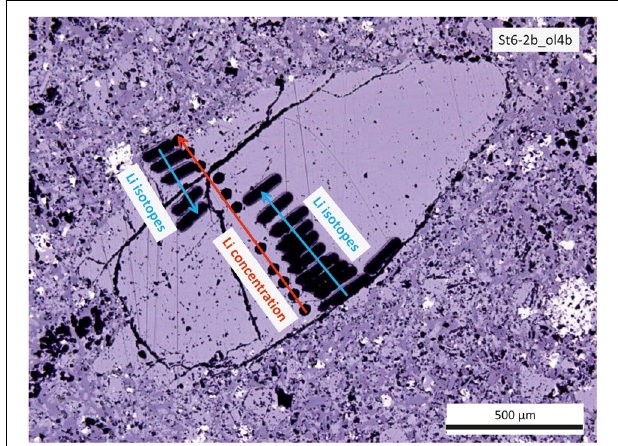
FIGURE 1 | Photomicrograph (reflected light) of sample St6-2b_ol4b showing the positions for major and trace element and isotope analyses. Black dots are from laser ablation for trace element analyses (indicated by the red arrow), which were conducted exactly along the profile previously analyzed for major elements with EMPA (not visible). Short black lines are from laser ablation for isotope analyses, which was conducted from both rims toward the core of the olivine grain (indicated by blue